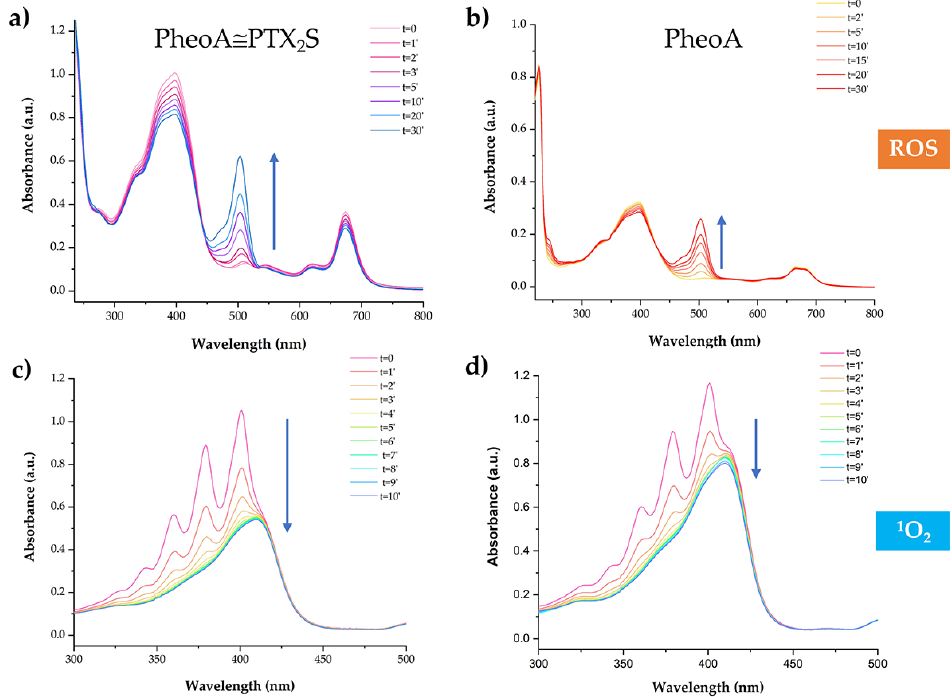
Figure 3. PheoA ≅ PTX 2 S ability to produce ROS and 1 O 2 upon light irradiation. Absorption spectra of 2 ′ ,7 ′ -dichlorofluorescein (DCF) measured at different irradiation times in the presence of ( a ) PheoA ≅ PTX 2 S and ( b ) free PheoA. 1 O 2 analysis performed at different irradiation times of a solution of ( c ) DMA + PheoA ≅ PTX 2 S and ( d ) DMA + PheoA.